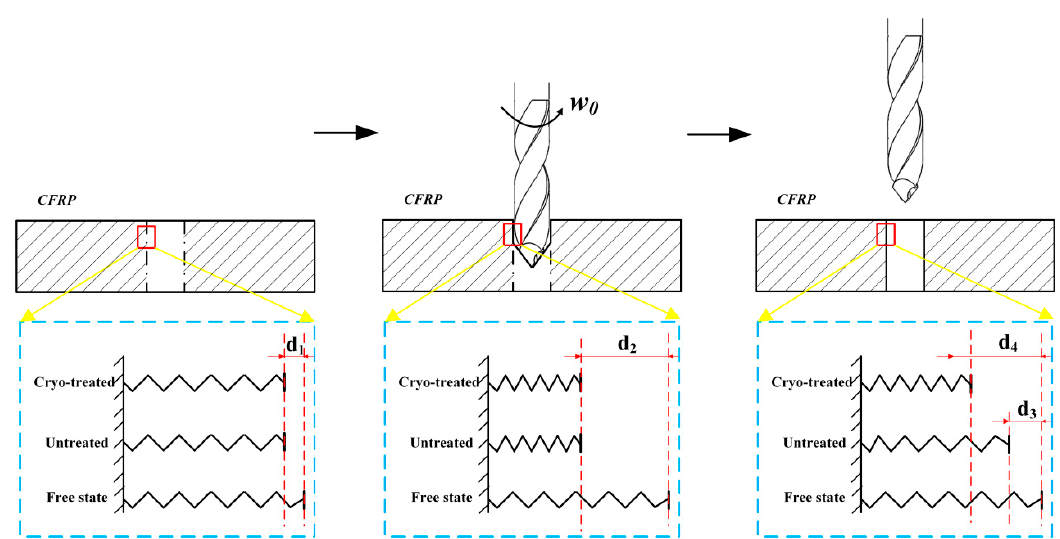
Figure 11. Influence mechanisms of viscoelasticity based on Tg.